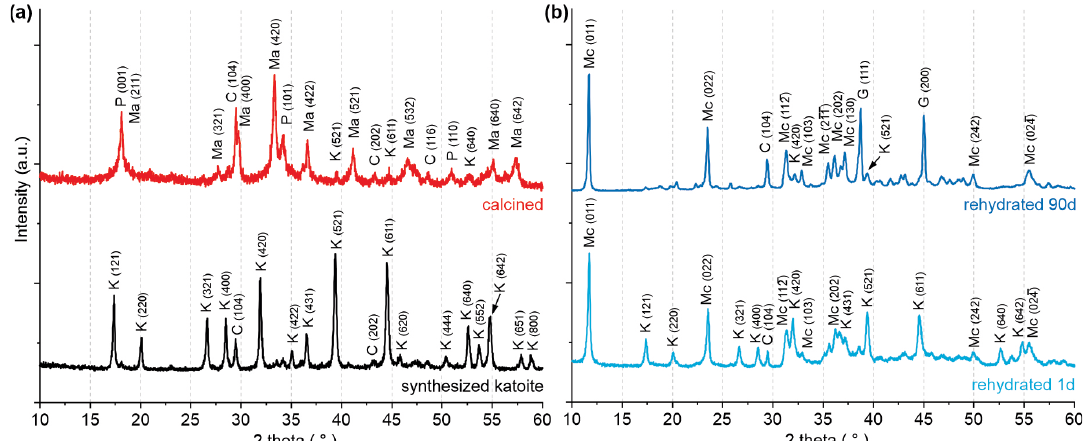
Figure 2. XRD patterns of (a) synthesized and calcined katoite and (b) rehydrated product at 1 day and 90 days. Denoted are K (katoite), C (calcite), P (portlandite), Ma (mayenite), Mc (monocarboaluminate) and G (griceite, internal